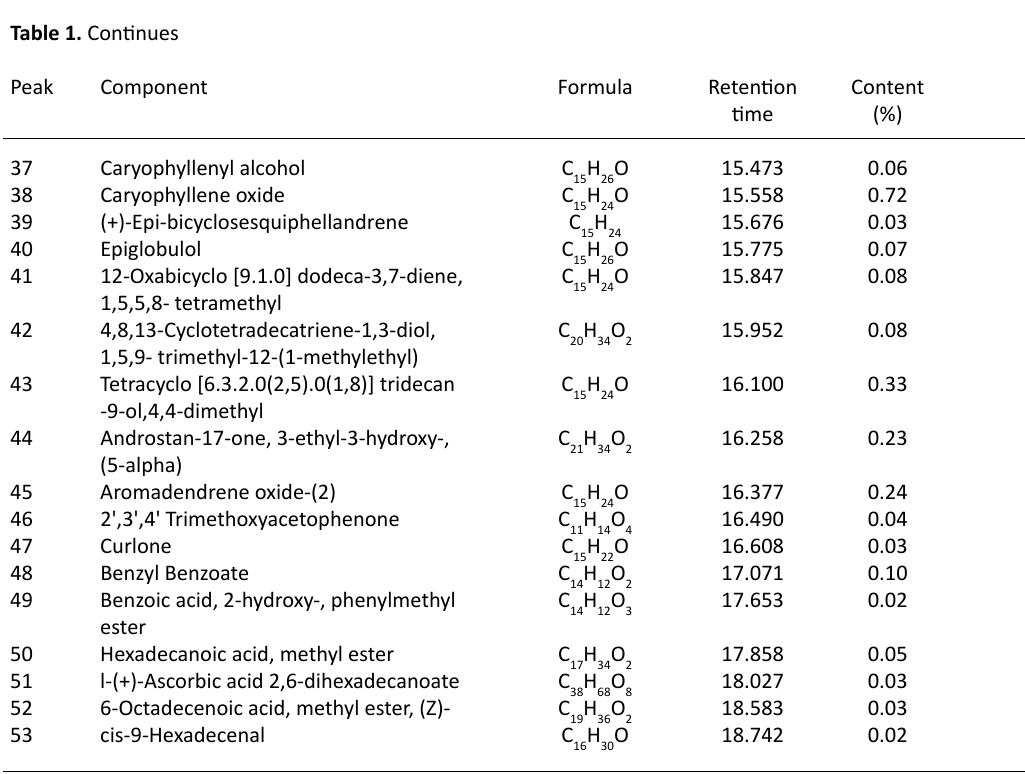
Table 1. Continues Peak